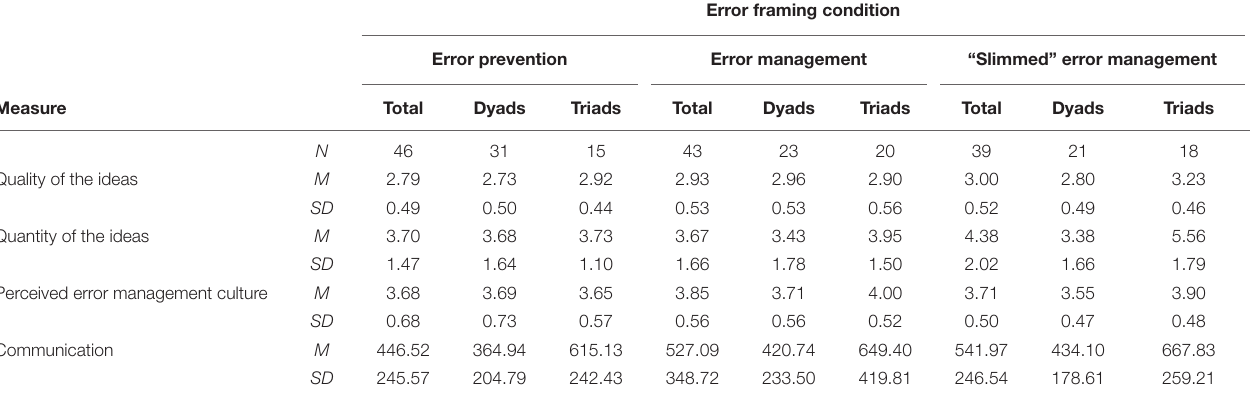
TABLE 6 | Means and standard deviations of dependent and process variables in Study 2 by between-participants factor